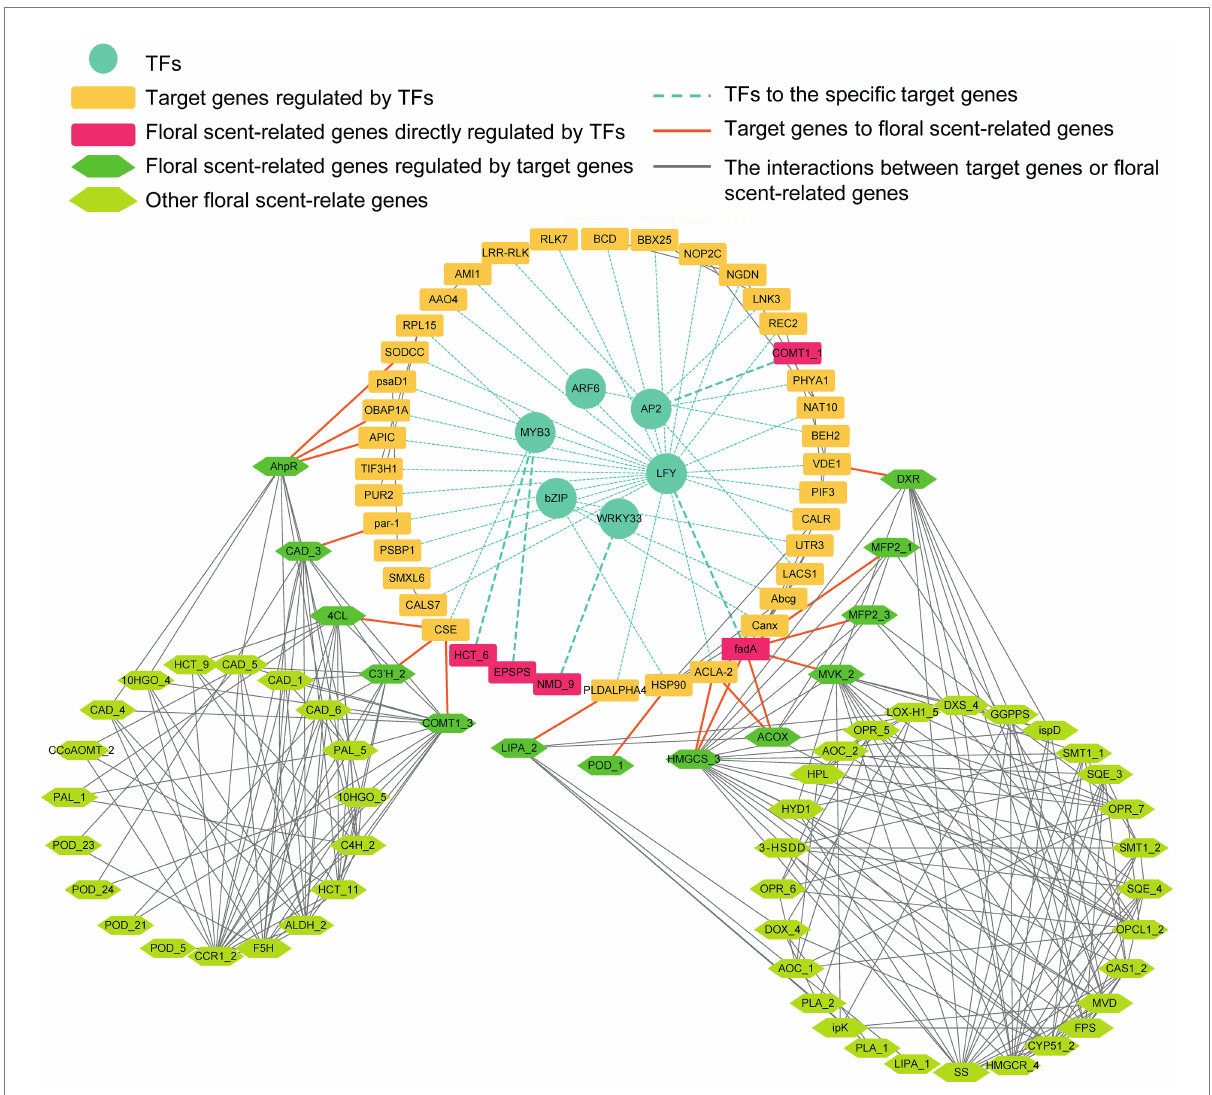
FIGURE 5 A regulatory network of transcription factors (TFs) and the floral scent-related genes. The circular, rectangular, hexagonal nodes indicate the TFs, target genes, and floral scent-related genes, respectively. The turquoise, orange, and gray edges indicate the TFs to the specific target genes predicted by GTRD, target genes to floral scent-related genes and the interactions between floral scent-related genes predicted by STRING. The raw data and the full names of the abbreviations can be found in Supplementary Table